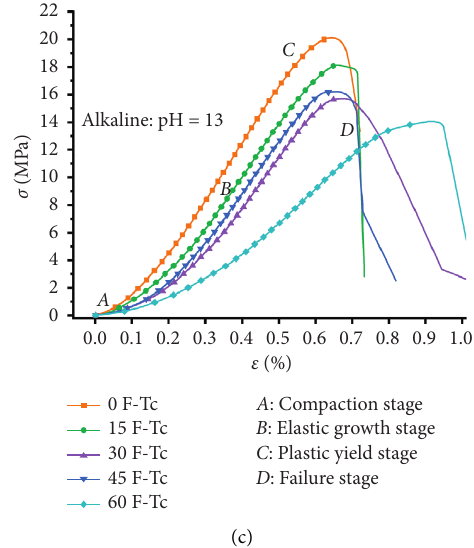
Figure 5: Stress-strain relationship for uniaxial compression tests after different chemical solution eroded and different number of freeze- thaw cycles (F-Tc): (a) uniaxial stress-strain curve under the acidic solution, pH � 3; (b) uniaxial stress-strain curve under the neutral solution, pH � 7; (c) uniaxial stress-strain curve under the alkaline solution, pH � 13.